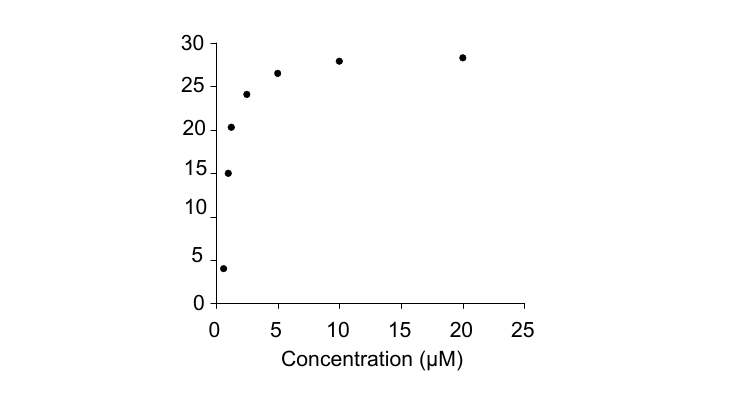
Figure 4. Influence of the bolaamphiphile 3 concentration on the reached maximal surface